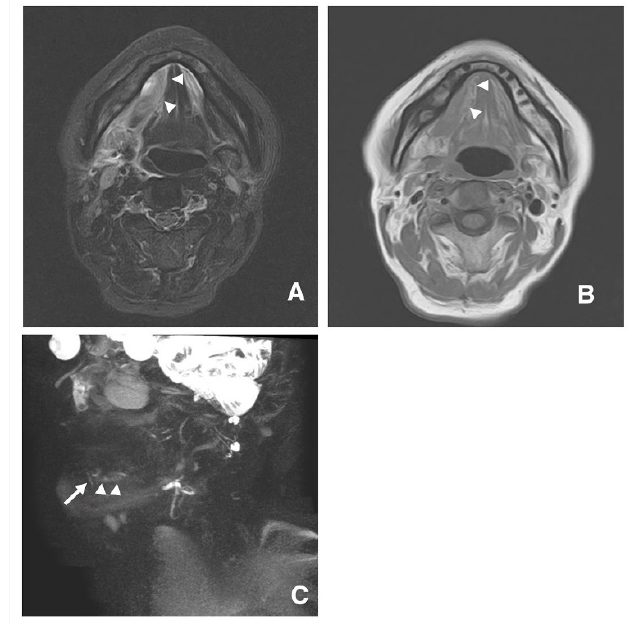
Figure 3. STIR ( A ), T1-weighted images ( B ), and MR sialography ( C ) of a 76-year-old man with inflammation of the right oral floor. The disappearance (arrows) of many sublingual gland ducts in continuity with the sublingual glands is visualized using MR sialography.